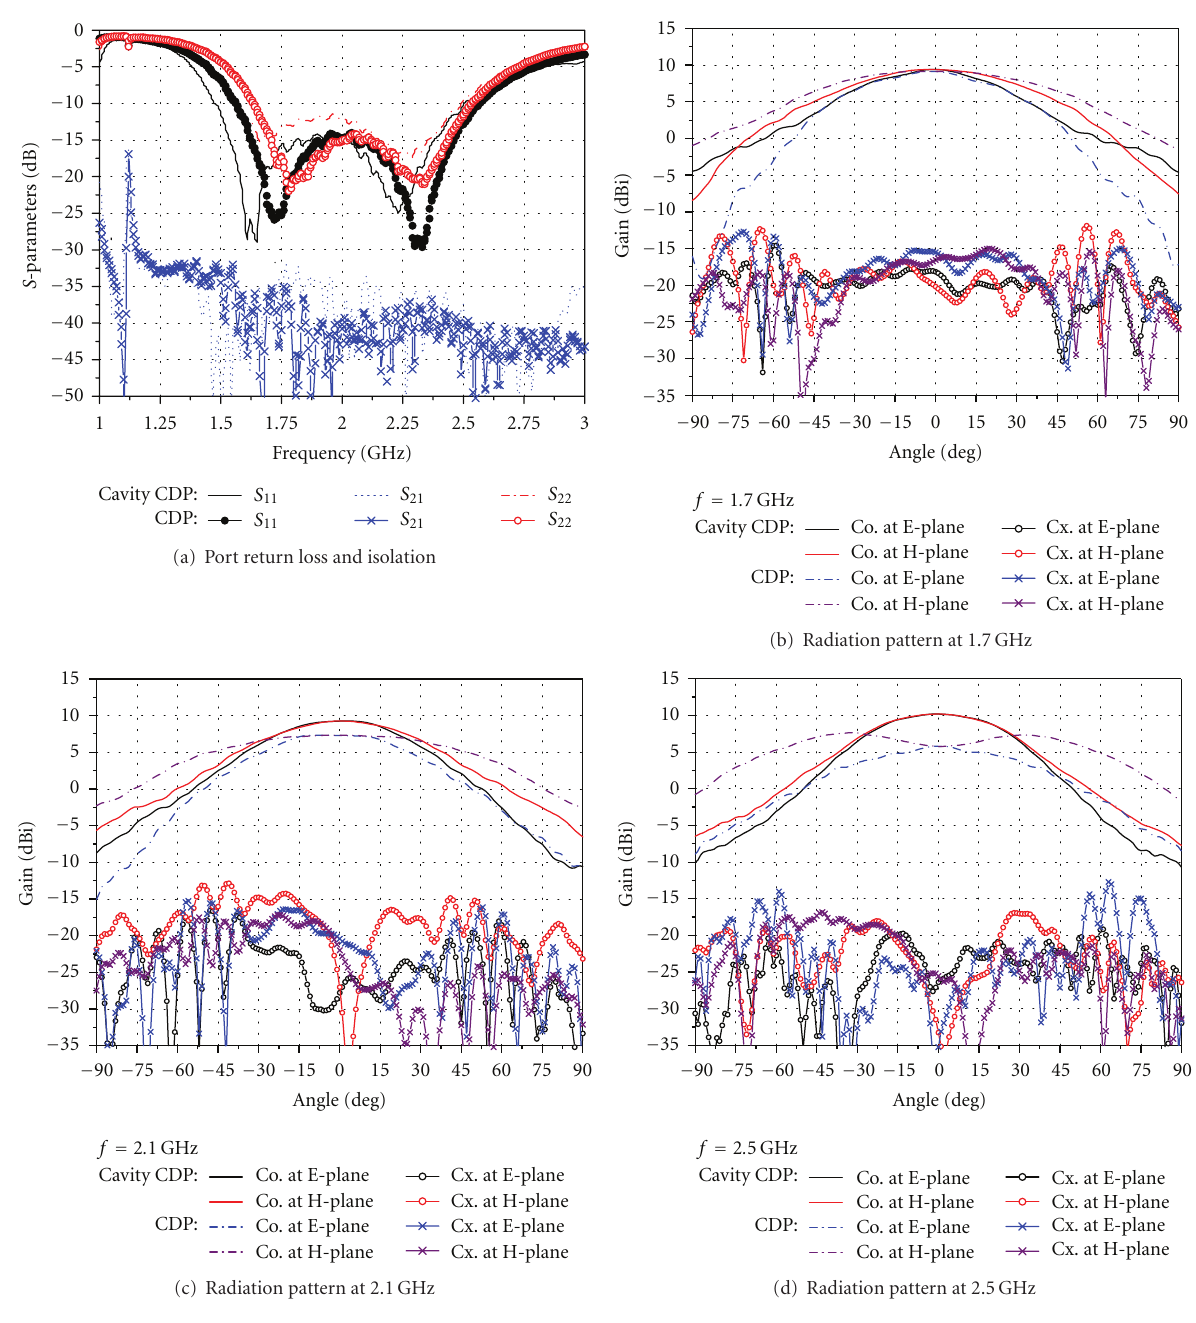
Figure 3: Measured electrical performances of the printed cross-dipole element with or without the cavity ring. 2.5 GHz. The ground plane size and edges will have influence on the antenna properties, and the di ff raction from the finite ground plane edges can cause main beam scalloping and can give a small e ff ect on the directivity [10, 11]. On the other hand, radiation patterns of the printed cross- dipole element with the cavity ring show antenna gains at Figure 4: Two-stage Wilkinson power divider. boresight of 9.4 dBi, 9.2 dBi, 10.2 dBi, respectively. The cross polarization performance is more than 21.2 dB within the 3 dB beamwidth and in the test frequencies irrespective of the ground plane with the size of 200 mm × 200 mm applied usage of the cavity in the antenna prototype which corresponds to 2.35 λ o at